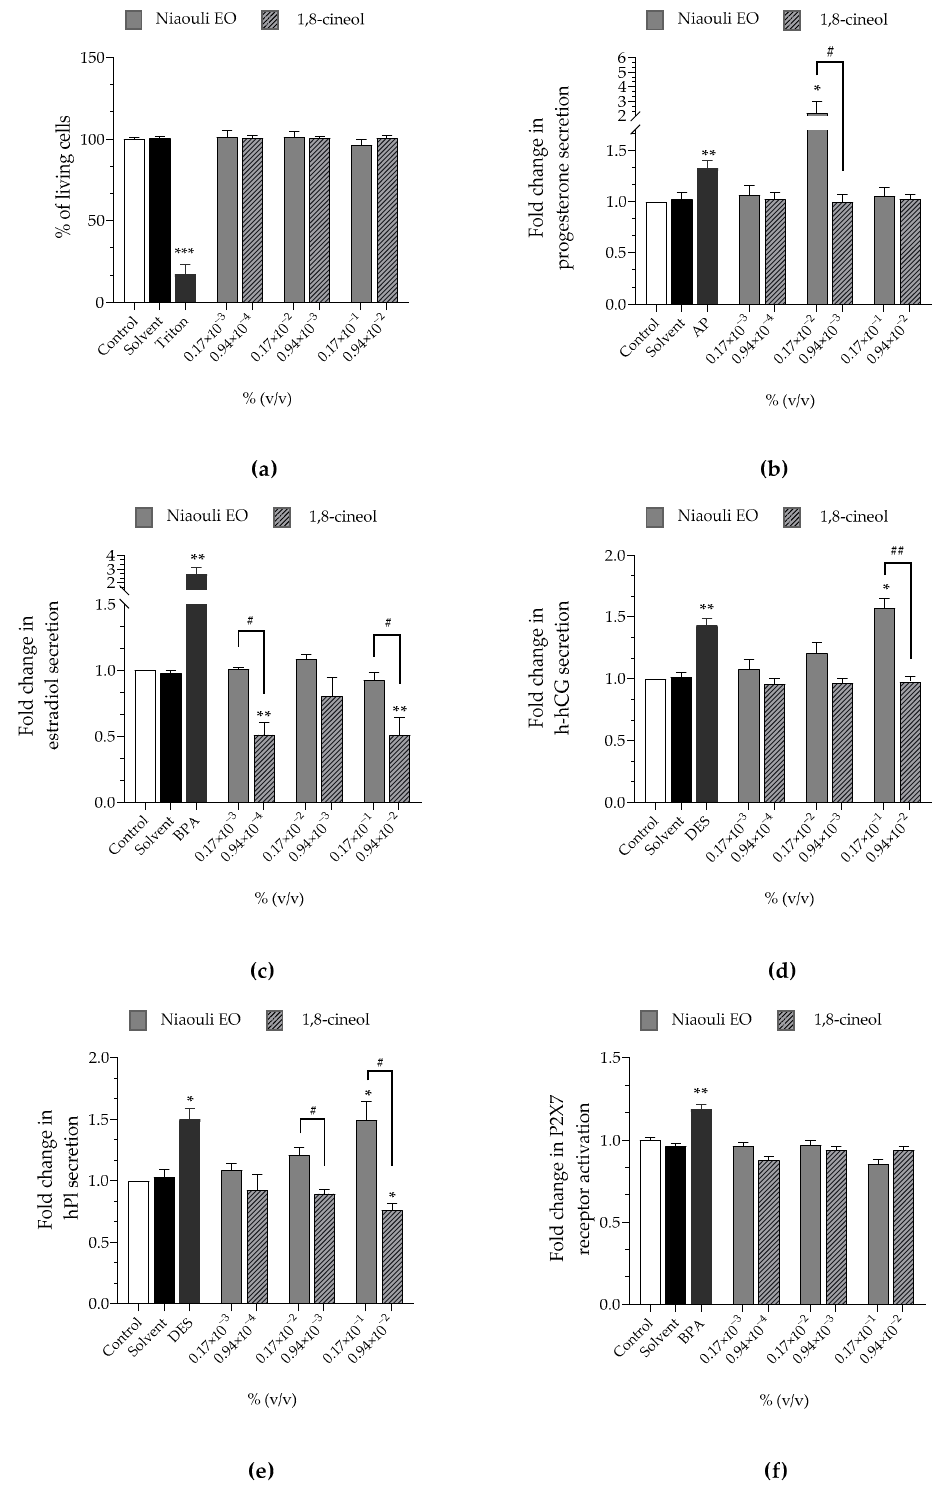
Figure 1. Effects of niaouli EO and 1,8-cineol on ( a ) cell viability (Alamar Blue assay), on released hormones: ( b ) progesterone ( c ) estradiol, ( d ) h-hCG and ( e ) hPL and on ( f ) P2X7 receptor activation (YO-PRO-1 assay) were evaluated, after incubation of JEG-Tox cells for 72 h. Triton ® X-100 at 0.016%, bisphenol A (BPA) at 20 µ M, 4-tert-amylphenol (AP) at 10 µ M and diethylstilbestrol (DES) at 3.75 µ M were used as positive controls. The significance thresholds were * p < 0.1, ** p < 0.01, *** p < 0.001, # p < 0.1, and ## p < 0.01.